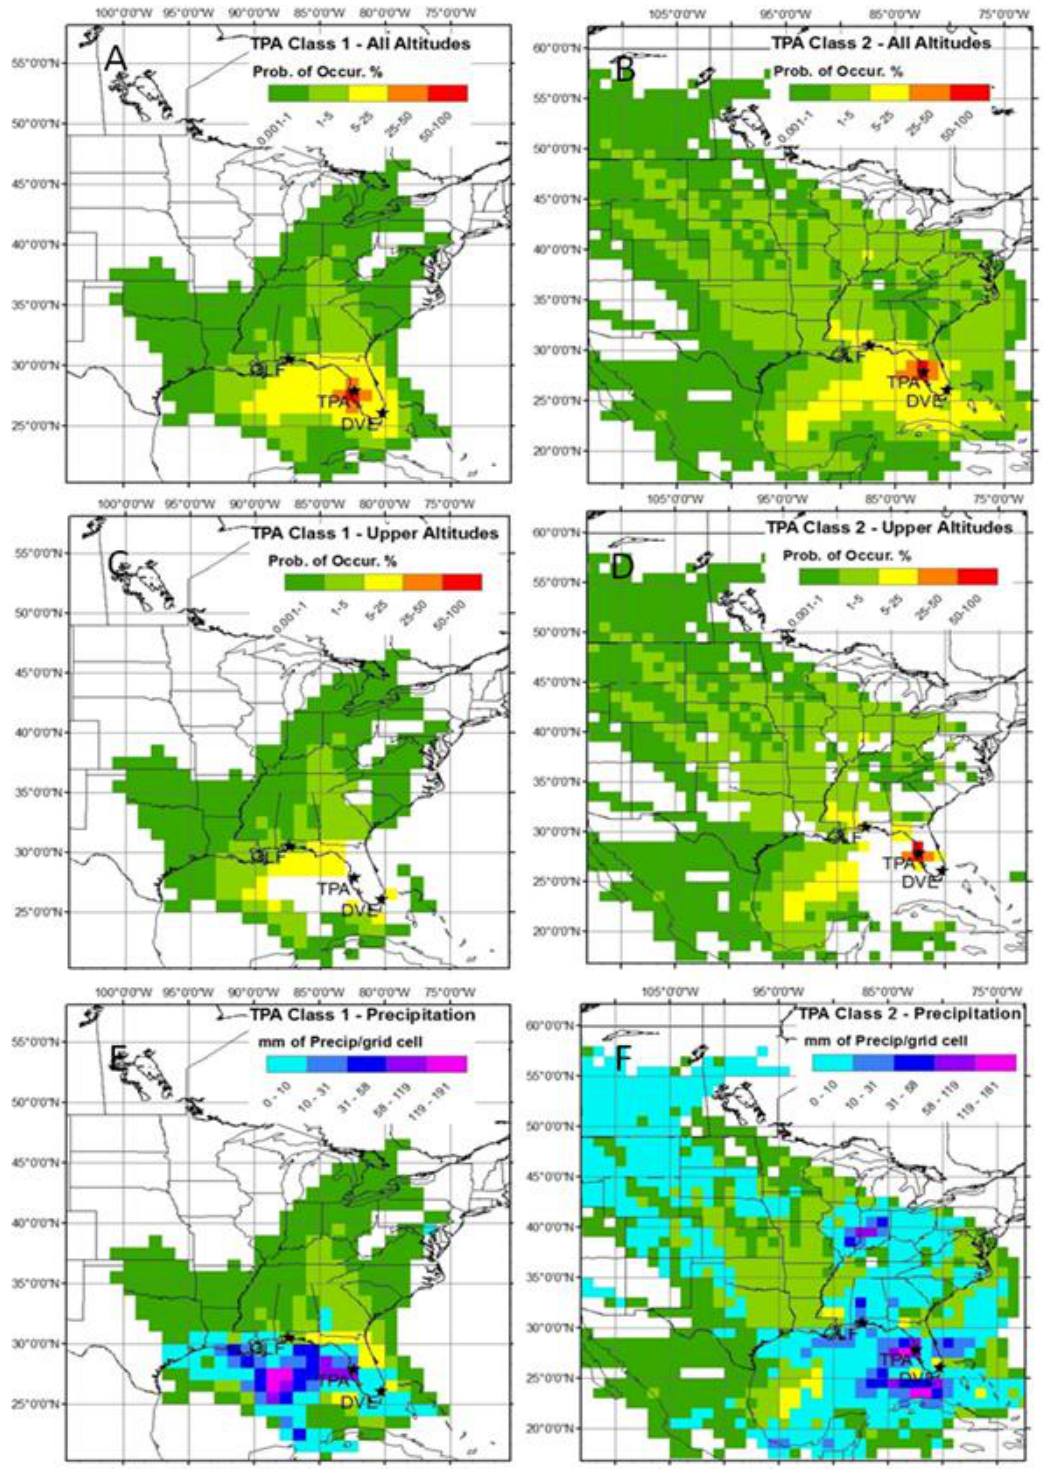
Fig. 7. Gridded frequency distributions of back trajectories for the five highest GOM concentration event days Classes 1 and 2 at the TPA site. (A) Horizontal location probabilities for Class 1 events. (B) Horizontal location probabilities for Class 2 events. (C) Same as (A) , but with color removed from grid cells with > 90% of trajectory points having altitudes below the modeled boundary layer. (D) Same as (C) except for Class 2 events. (E) and (F) Modeled precipitation distributions for Classes 1 and 2 events overlain on the horizontal location